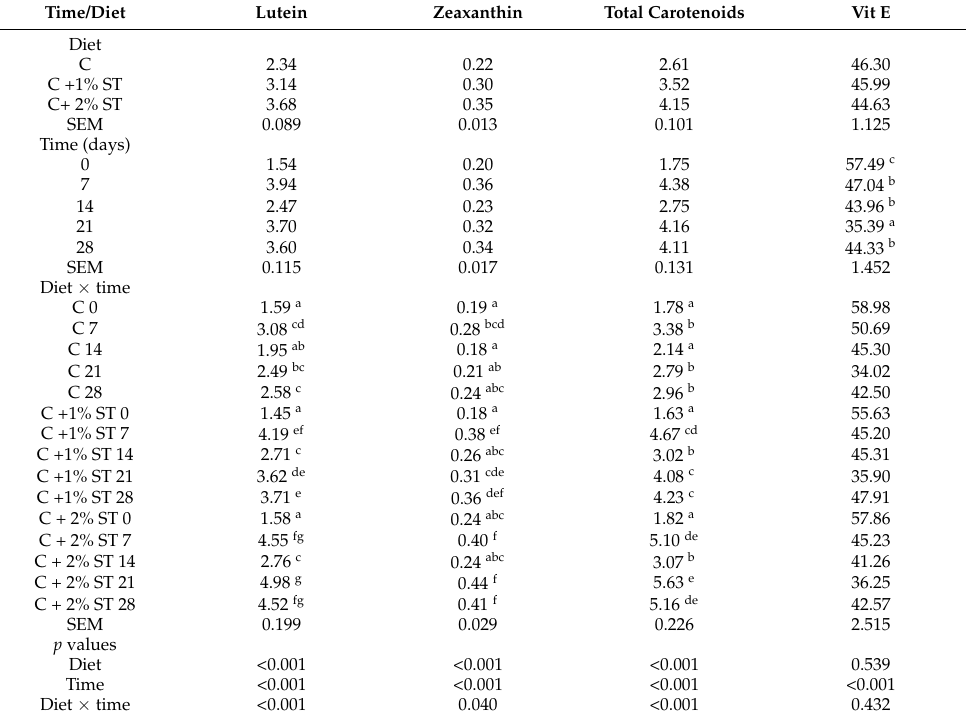
the control and C + 1% STE diets. Dietary STE did not have a significant impact ( p > 0.05) on the egg weight, AH, HU and albumen pH of the stored eggs. Compared to the control, egg weight decreased after 28 d of storage ( p = 0.40), but egg weight at 14 d of storage did not differ ( p > 0.05) from the control or 28 d storage. Over the 28 d storage period, AH and HU decreased over time ( p < 0.001). Yolk pH and yolk color decreased during the first two weeks of storage ( p < 0.001), but their values reached the pre-storage levels after four weeks of storage. There were no interactions observed ( p > 0.05). Table 5. The effect of dietary stevia and length of consumption on egg * lutein, zeaxanthin, total carotenoids and vitamin E concentration ( µ g/g). Time/Diet Lutein Zeaxanthin Total Carotenoids Vit E Diet C 2.34 0.22 2.61 46.30 C +1% ST 3.14